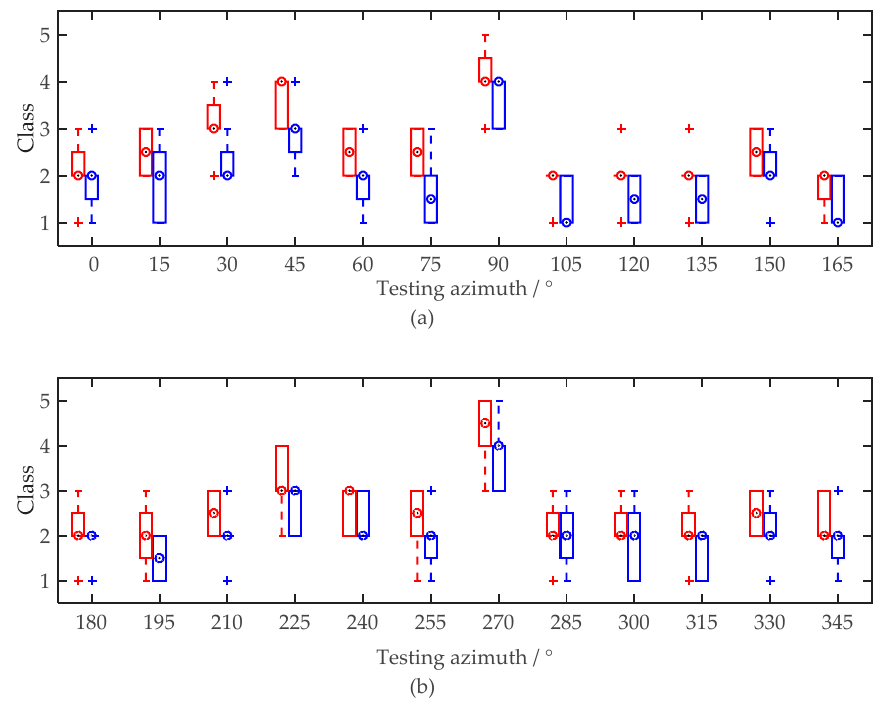
Figure 11. Box-plot for results of the subjective experiment for discrimination degree of given azimuths. ( a ) and ( b ) represent the azimuths in right and left of the subject, respectively. X-axis and Y-axis denote the testing azimuths and the discrimination degree showed in Table 4, respectively. Red and blue boxes denote the HRTF species of the presented individualization method and KEMAR dummy head. Box edges mark the 25th and 75th percentiles, black dots in a circle mark the median. Outliers are indicated by +.